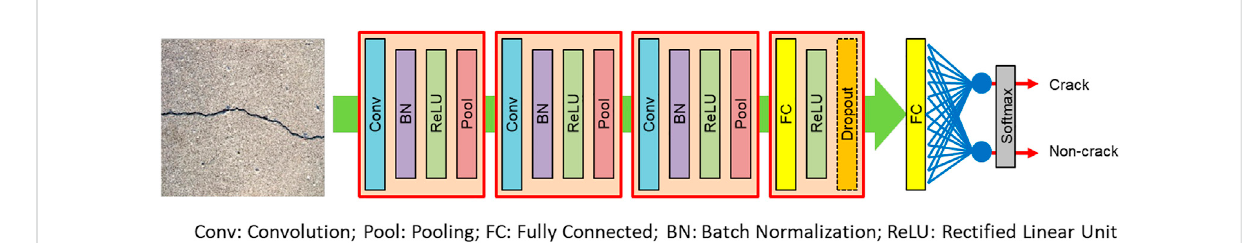
FIGURE 4 Typical CNN architecture for defect classi fi